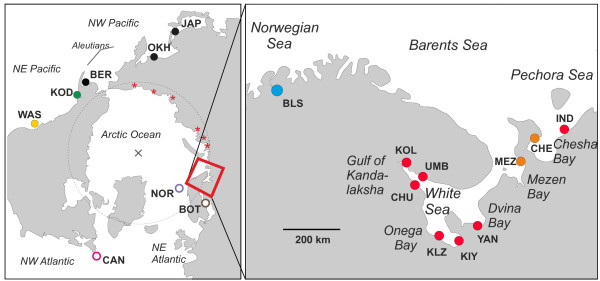
Sampling localities for Clupea pallasii (dots) and C. harengus (circles). For locality codes see Table 1. Color codes reflect genetic population groupings (cf. Figures 2, 3). Observations of historical herring occurrence along the Siberian coast in the warm period of 1930s-1940s [7] are indicated with stars.